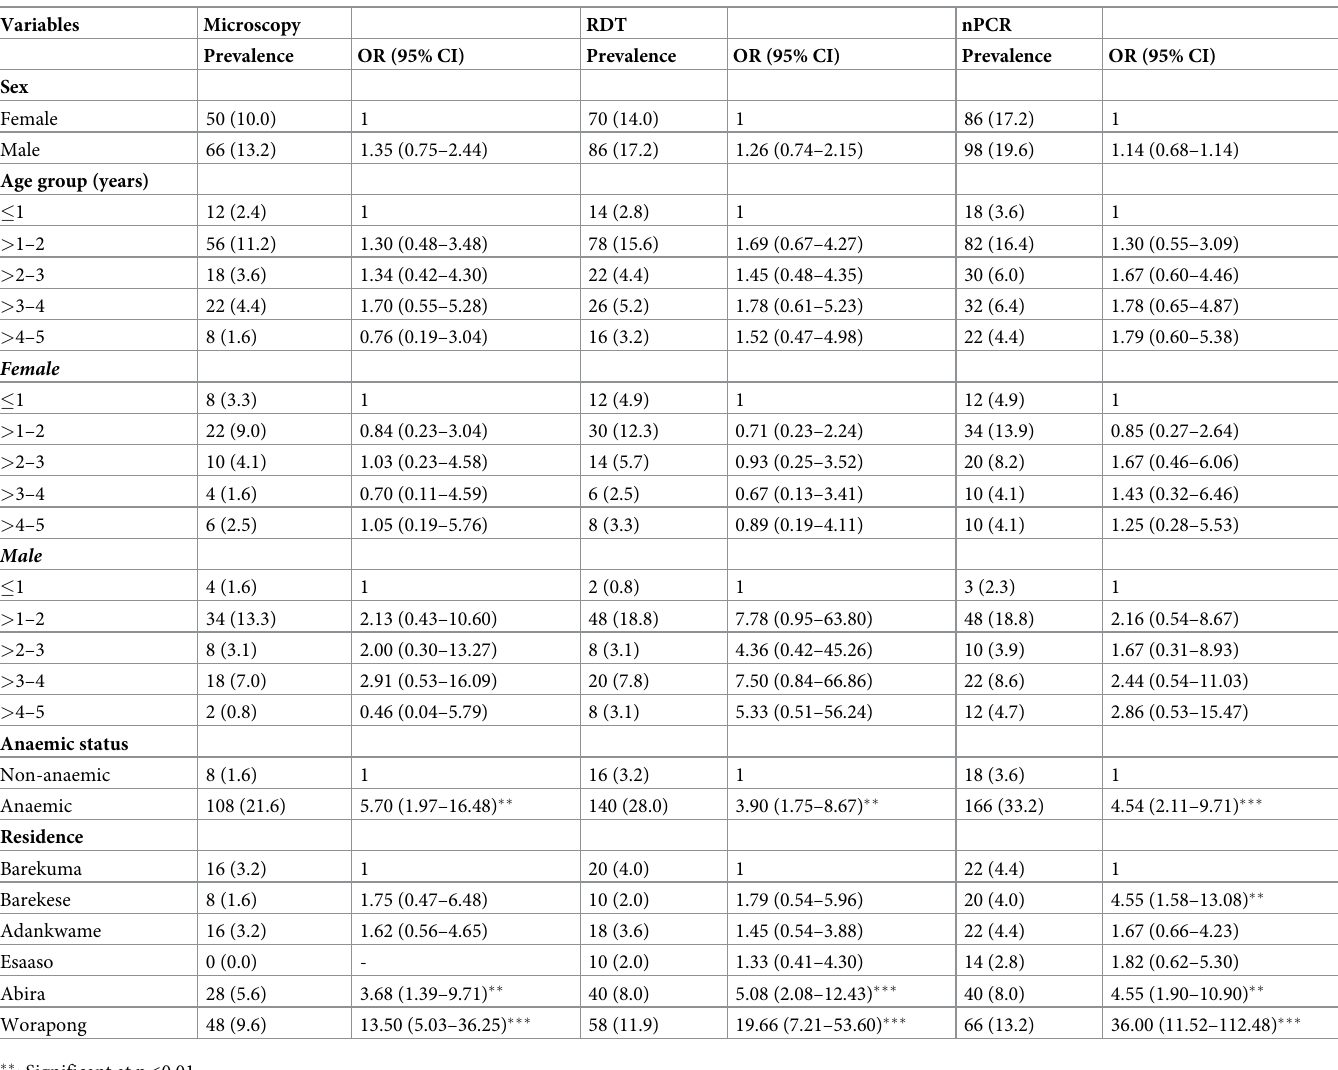
Table 3. Sociodemographic-stratified point prevalence and odds ratios for asymptomatic malaria infection by microscopy, RDT and nPCR. Variables